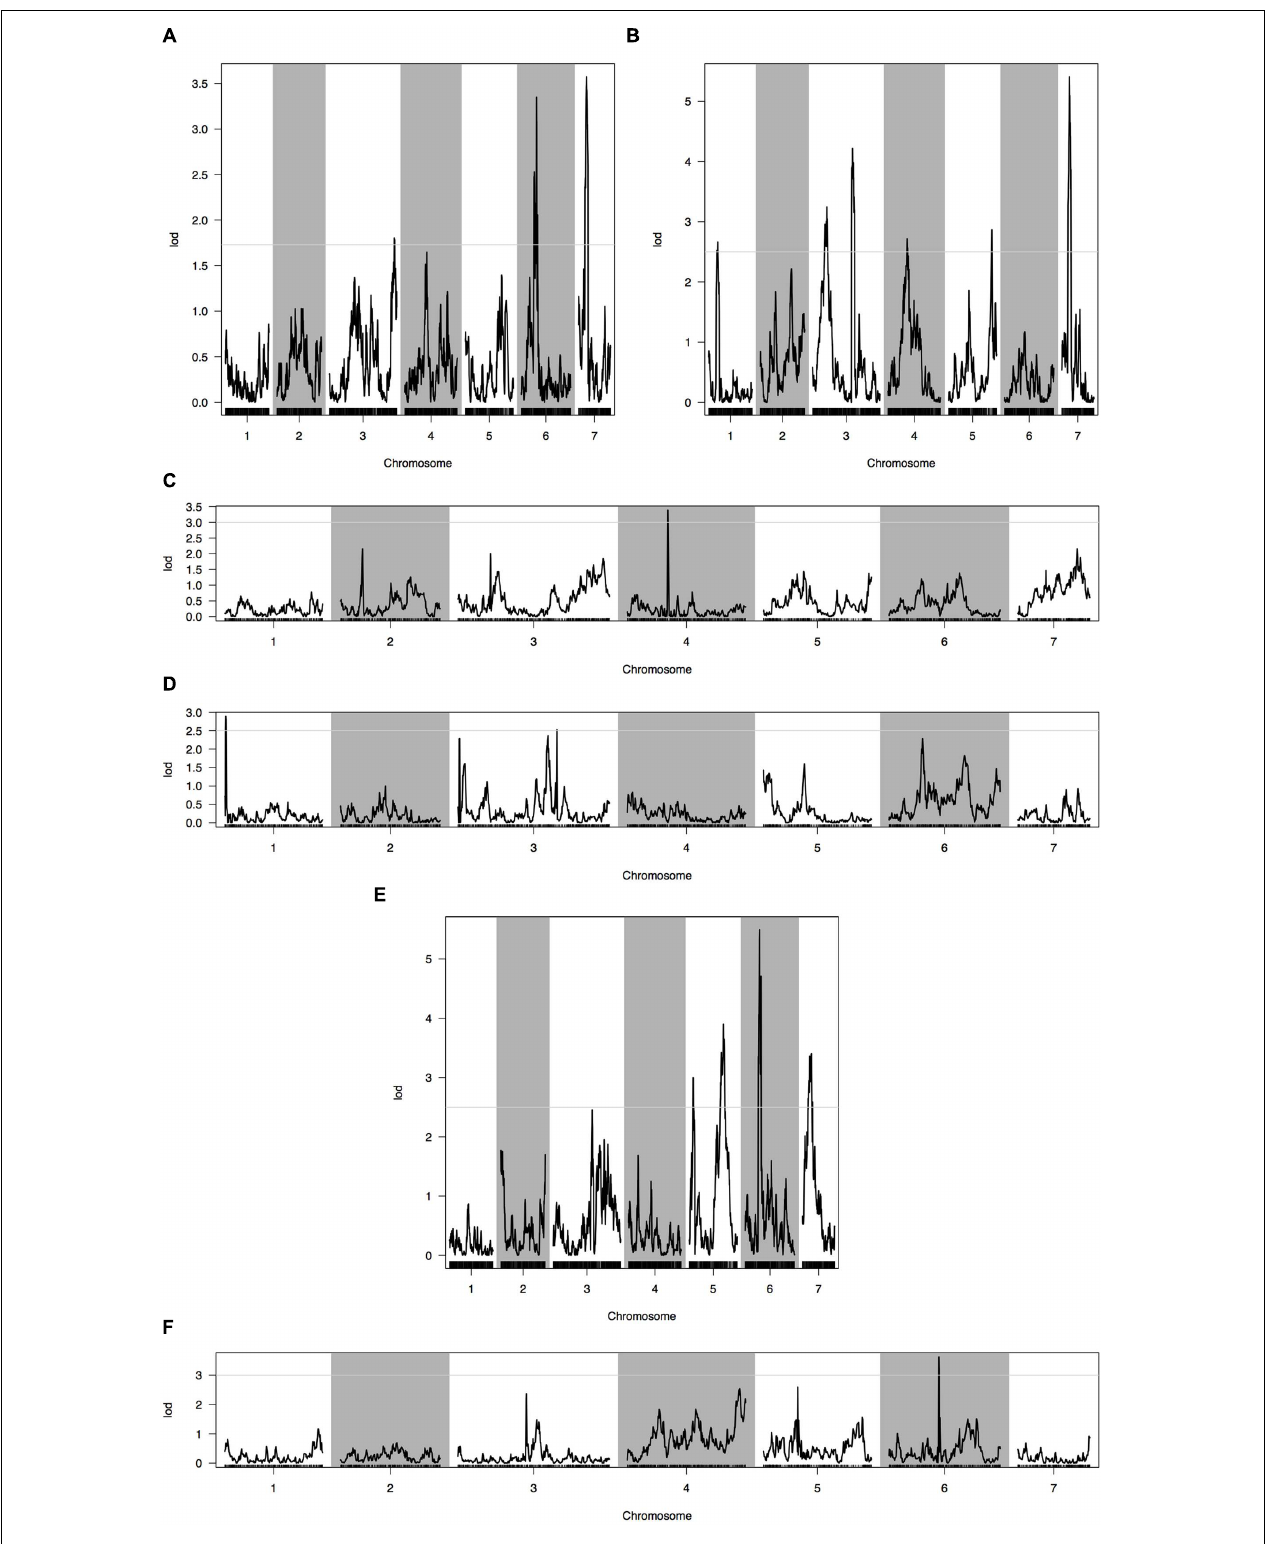
FIGURE 4 | Quantitative trait loci (QTL) analysis with two fruit traits using the high-density genetic map. (A) QTL analysis of fruit length in 2013 autumn; (B) QTL analysis of fruit length in 2014 spring; (C) QTL analysis of fruit length in 2015 spring; (D) QTL analysis of fruit diameter in 2013 autumn; (E) QTL analysis of fruit diameter in 2014 spring; (F) QTL analysis of fruit diameter in 2015 spring. Horizontal line on the chart represents LOD threshold.